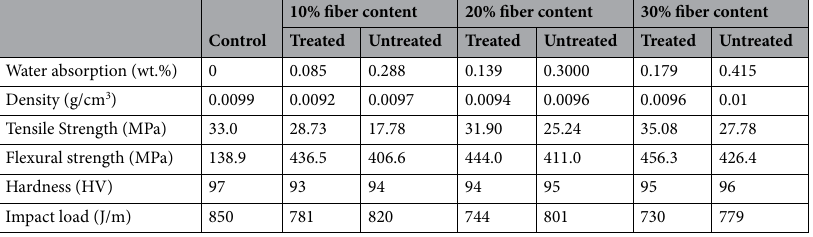
Table 2. Results obtained for the physico-chemical